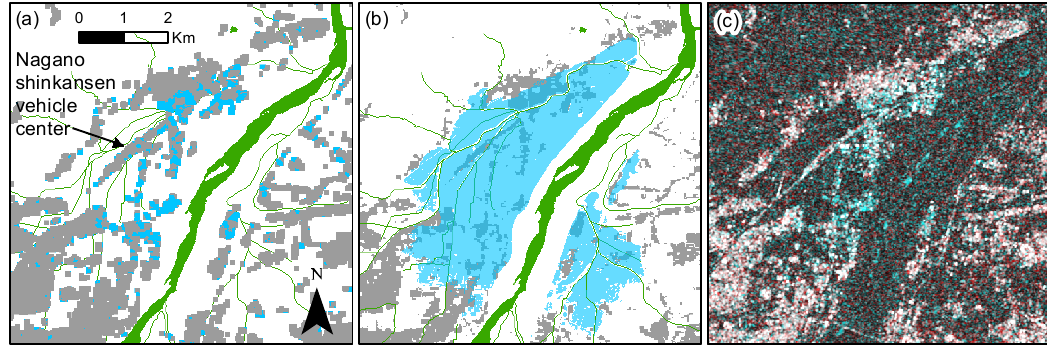
Figure 8. Closer look of the affected area in the city of Nagano, Nagano Prefecture. ( a ) The predicted flood map. ( b ) The reference flood map provided by GSI. ( c ) The RGB coherence color composite. Their locations are indicated in Figure 5a.